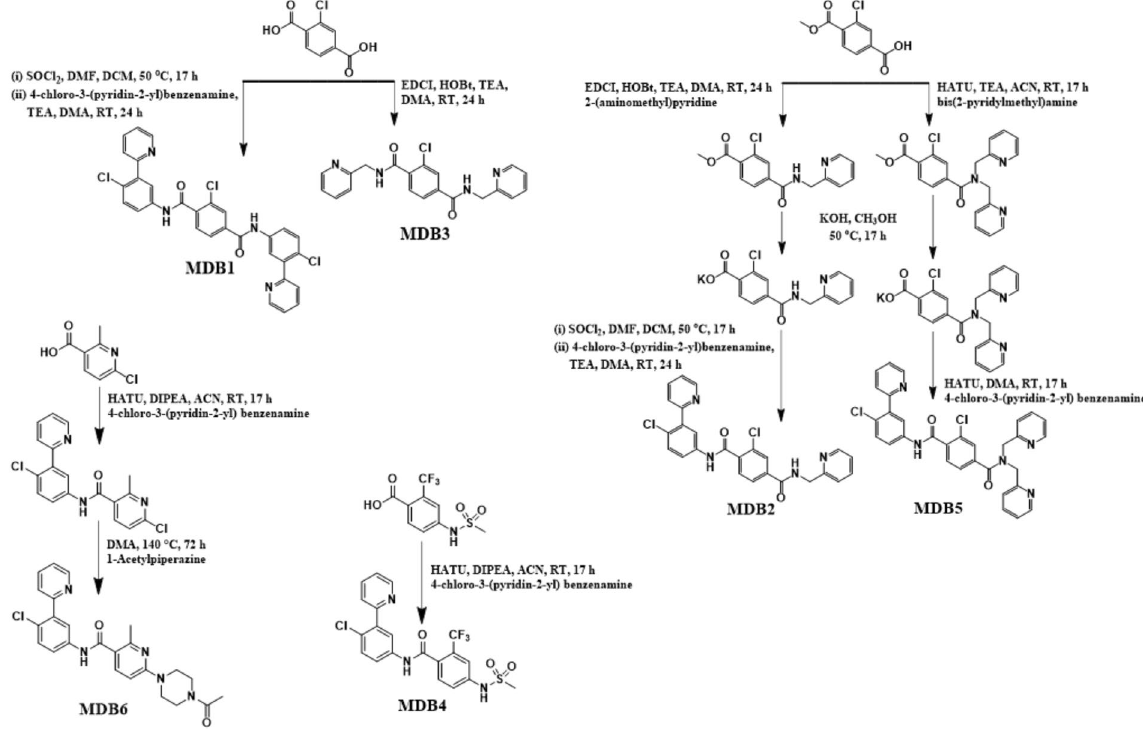
Figure 1. Schematic representation of GDC-0449 analogs synthesis. 2-chloro- N 1 , N 4 -bis[4-chloro-3-(2- pyridinyl)phenyl]-1,4-benzenedicarboxamide (MDB1), 2-chloro- N 1 -[4-chloro-3-(2-pyridinyl)phenyl]- N 4 -(2-pyridinylmethyl)-1,4-benzenedicarboxamide (MDB2), 2-chloro- N 1 , N 4 -bis(2-pyridinylmethyl)- 1,4-benzenedicarboxamide (MDB3), N -[4-chloro-3-(2-pyridinyl)phenyl]-4-[(methylsulfonyl)amino]- 2-(trifluoromethyl)benzamide (MDB4), 2-chloro- N 1 -[4-chloro-3-(2-pyridinyl)phenyl]- N 4 , N 4 -bis(2- pyridinylmethyl)-1,4-benzenedicarboxamide (MDB5) and 6-(4-acetyl-1-piperazinyl)- N -[4-chloro-3-(2- pyridinyl)phenyl]-2-methyl-3-pyridinecarboxamide (MDB6) were synthesized using N -[3-(2-pyridinyl) phenyl]benzamide scaffold of